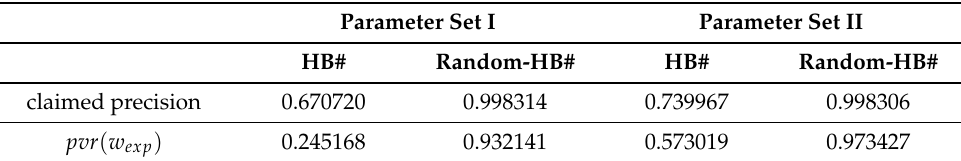
Table 5. Comparison of the claimed and real precision of the OOV noise vector recovery showing that the real precision is smaller than the claimed one.